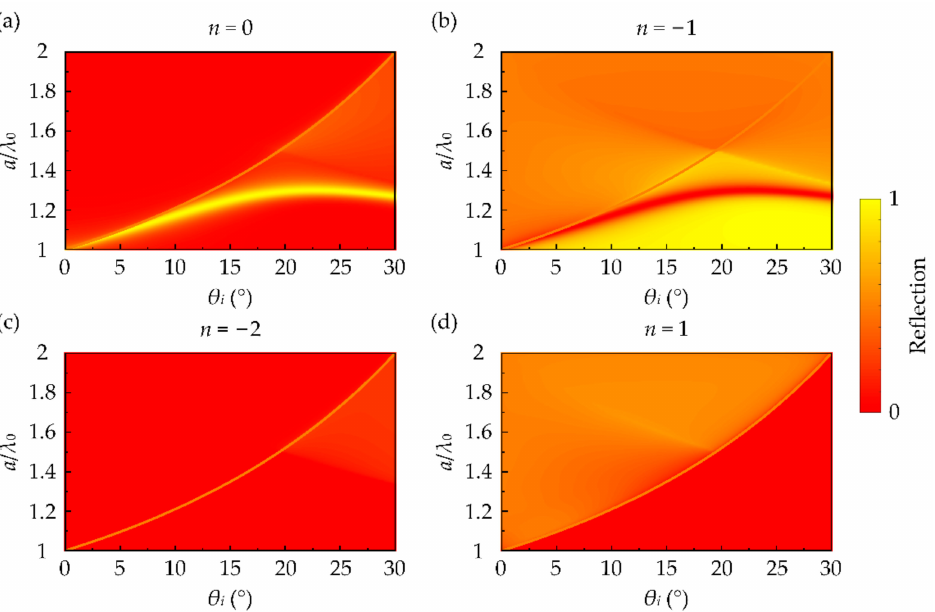
Figure 8. Simulated reflection of the diffraction orders of ( a ) n = 0, ( b ) n = − 1, ( c ) n = − 2, and ( d ) n = 1 as a function of the incident angle θ i and the periodicity a . Here, d = 0.25 λ 0 and t = 0.5 a . The orange lines correspond to the function of sin θ i = 1 − λ 0 / a . λ 0 = 100